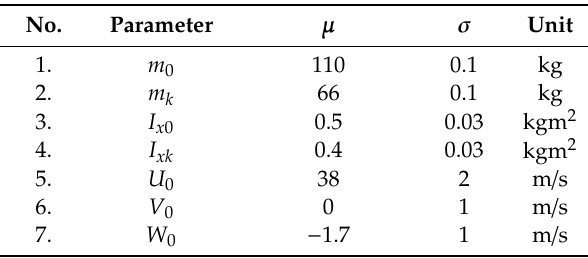
Table 1. Parameters for the Monte-Carlo simulation.